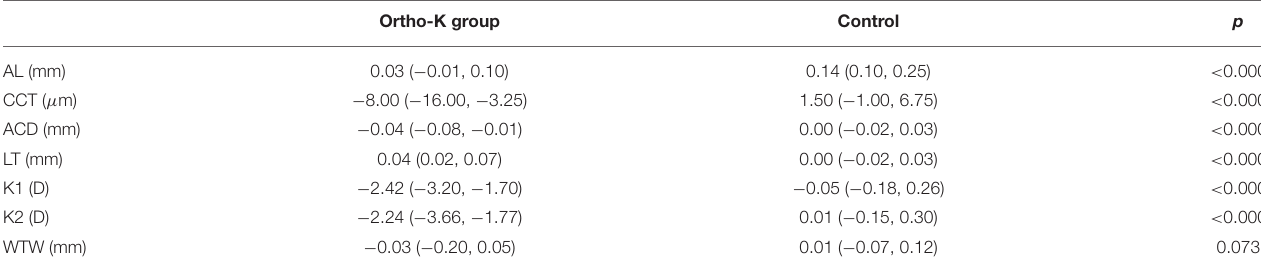
TABLE 2 | Mean changes from baseline in ocular parameters during 6 months of follow-up in the Ortho-K group and the control group. Ortho-K group Control p